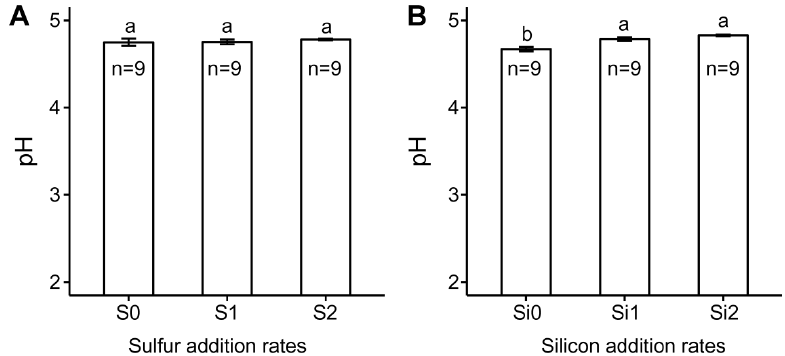
Figure 4. Effect of ( A ) sulfur and ( B ) silicon additions on soil pH. Different letters for each sulfur or silicon addition rate indicate significant differences among different treatments (Tukey HSD test, α = 0.05). Bars represent ±1 standard error ( n = 9).